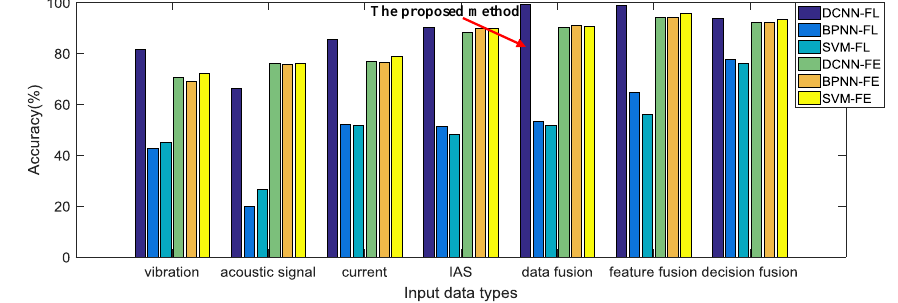
Figure 8. Testing accuracy of all the comparative methods.